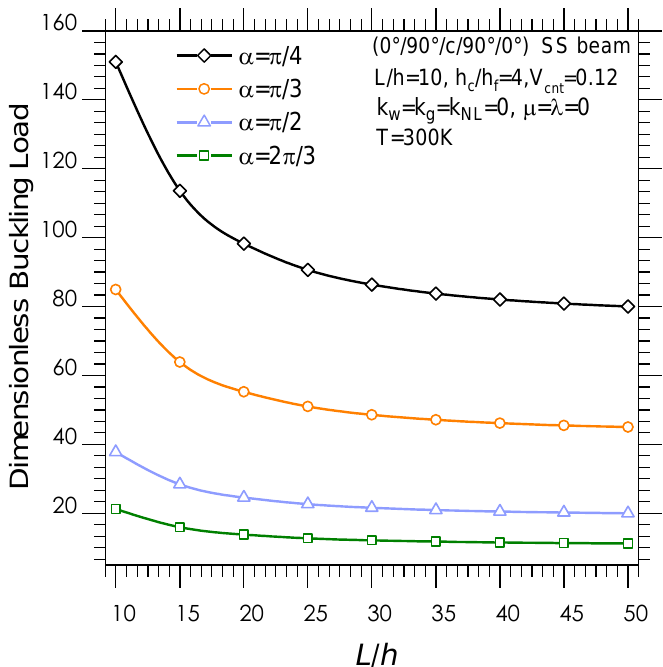
Figure 3. Dimensionless buckling load versus thickness ratio.